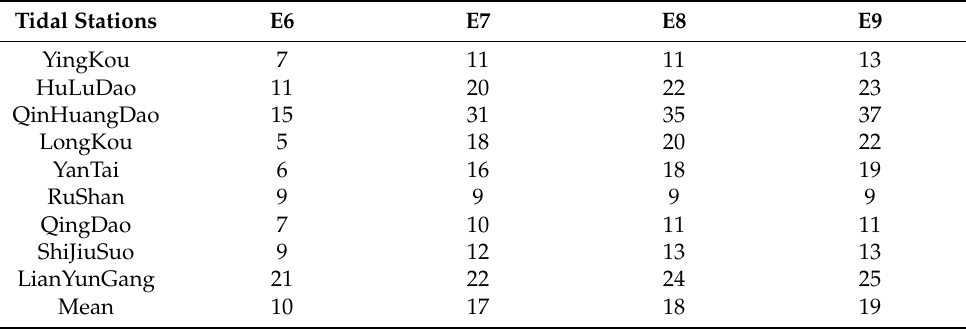
Table 7. Root mean square errors between the simulation and observation of storm surge levels at 9 tidal stations during Typhoon 7008 (unit: